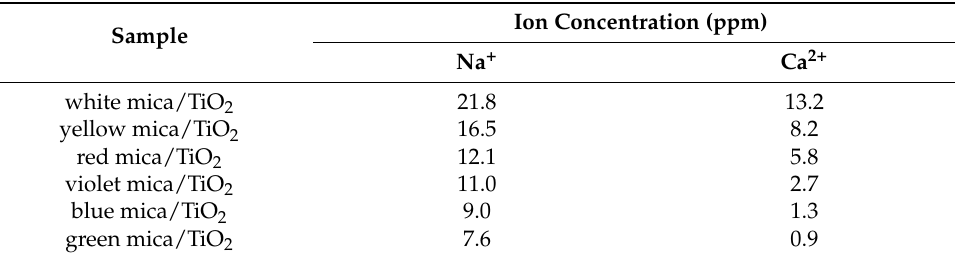
Table 2. Concentrations of Na + and Ca 2+ ions in various color mica/TiO 2 materials a . Sample